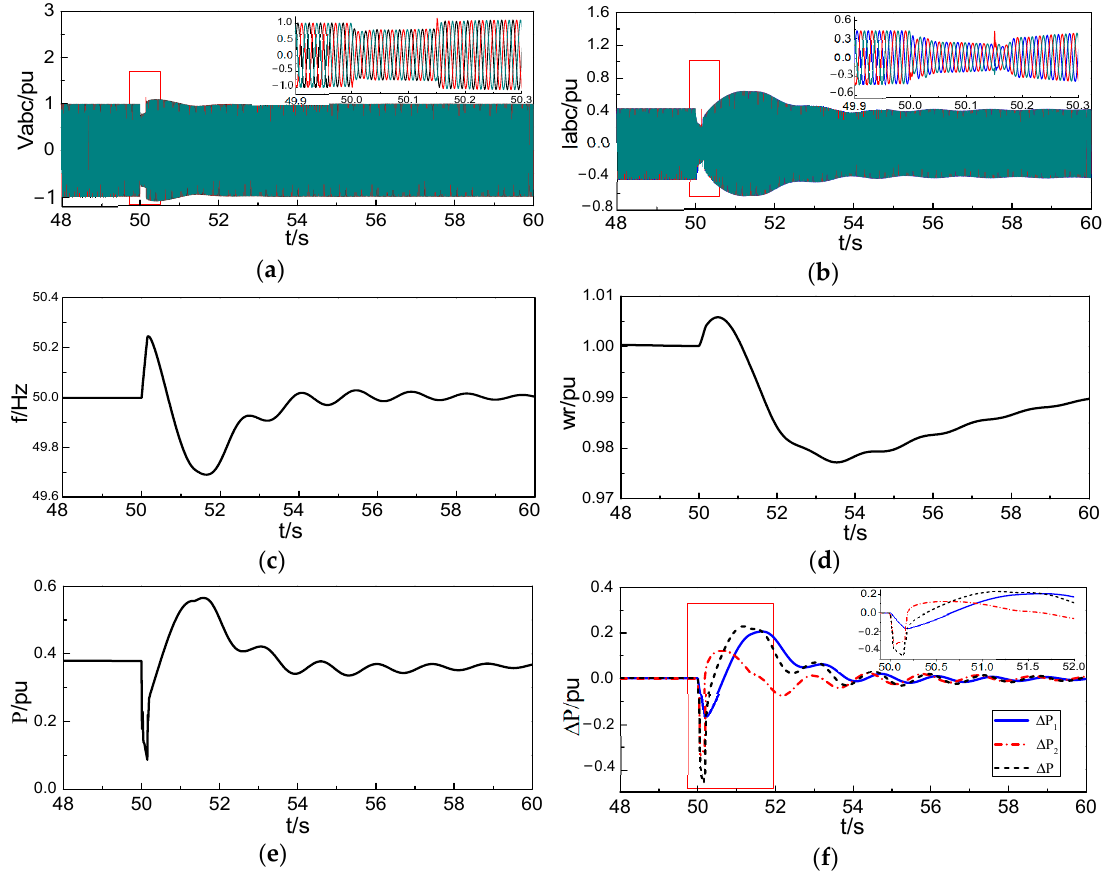
Figure 2. Variation of parameters under a short-circuit fault using conventional additional frequency control ( a ) Voltage of the DFIGs; ( b ) Current at the common connection point between the DFIGs and the grid; ( c ) System frequency; ( d ) Rotor speed of DFIGs; ( e ) Active power provided by DFIGs; ( f ) Additional power.